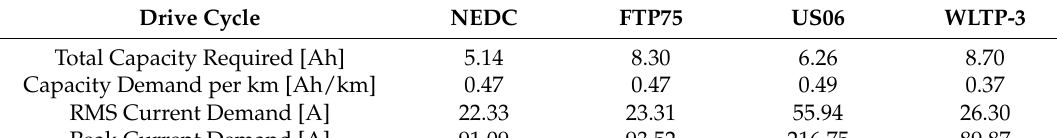
Table 4. Capacity & Current Demands of Legislative Drive Cycles (Current-based Approach).